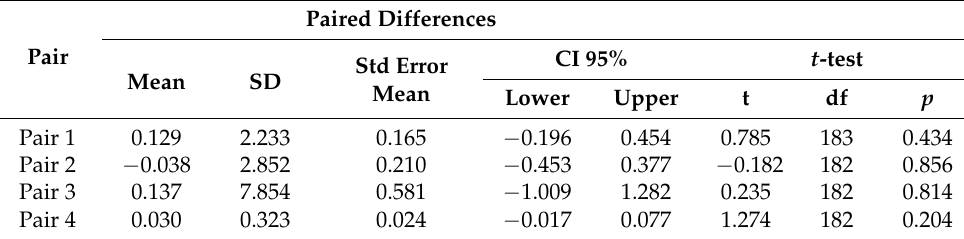
Table 7. Details of the conducted paired samples t -test so that differences can be assessed.